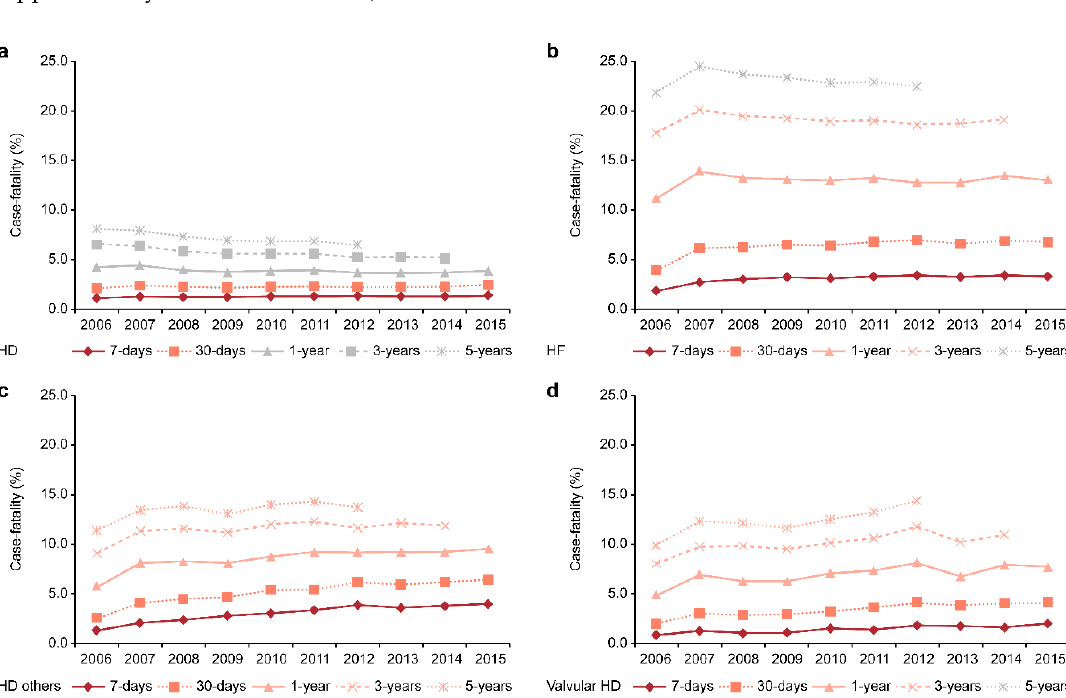
Figure 1. Trend in case fatality rates of HD subtypes in Korea, 2006–2015. ( a ) Overall of heart disease (ICD-10th code: I00–I09, I11, I13, I20–I51); ( b ) heart failure (ICD-10th code: I50); ( c ) other subtypes of HD (ICD-10th code: I00–I09, I30–I33, I40–I46, I51); ( d ) valvular HD (ICD-10th code: I34–I38); ( e ) hypertensive HD (ICD-10th code: I11, I13), ( f ) arrythmia (ICD-10th code: I47–I49); ( g ) pulmonary HD (ICD-10th code: I26–I28); ( h ) ischemic HD (ICD-10th code: I20–I25). 4. Discussion In Korea, HD carries the second highest death rate (62.4 per 100,000 in 2018) following cancer, and the recent trends reveal an increase [10]. There are a variety of ways to measure the population impact of a disease, and one of the most critical measurements is the incidence rate of a disease [11]. However, there is a lack of information on the incidence rates of HD and its subtypes rather than the